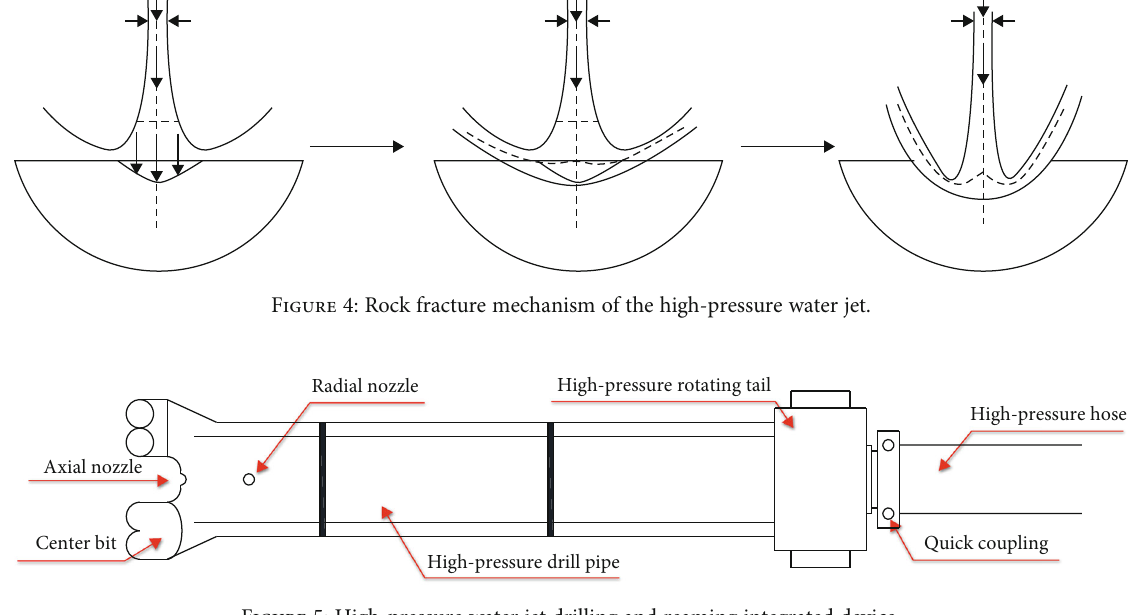
Figure 5: High-pressure water jet drilling and reaming integrated